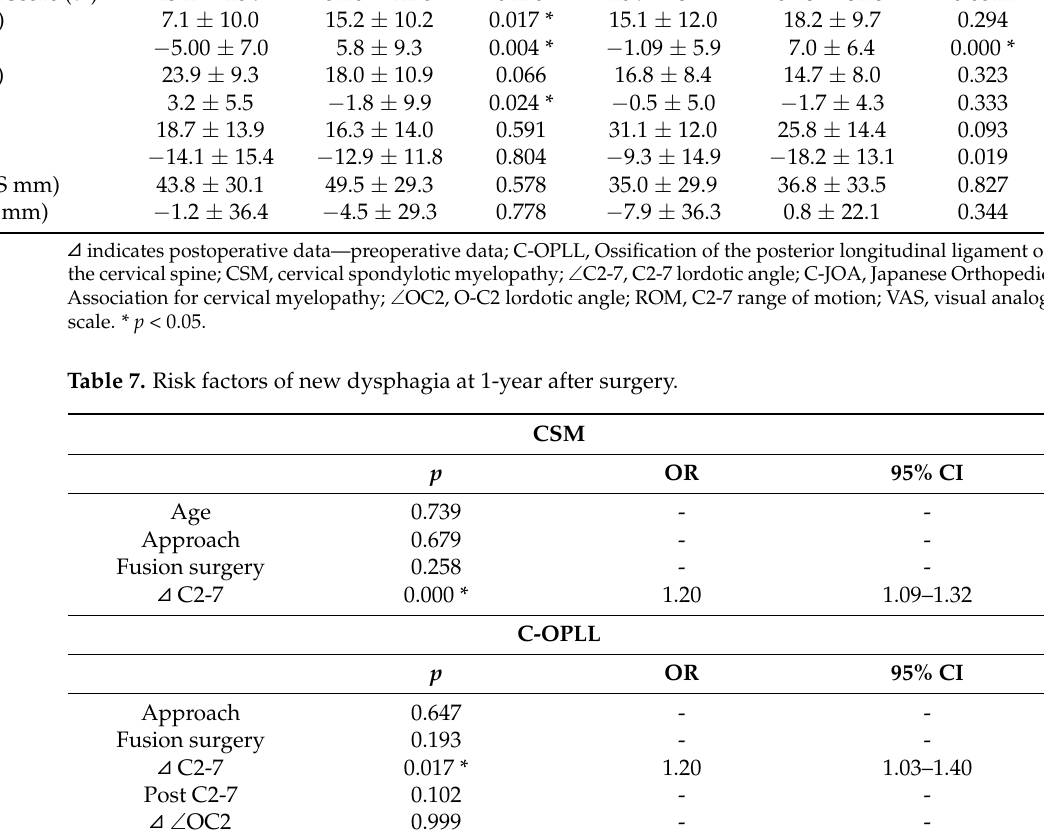
Table 7. Risk factors of new dysphagia at 1-year after surgery.